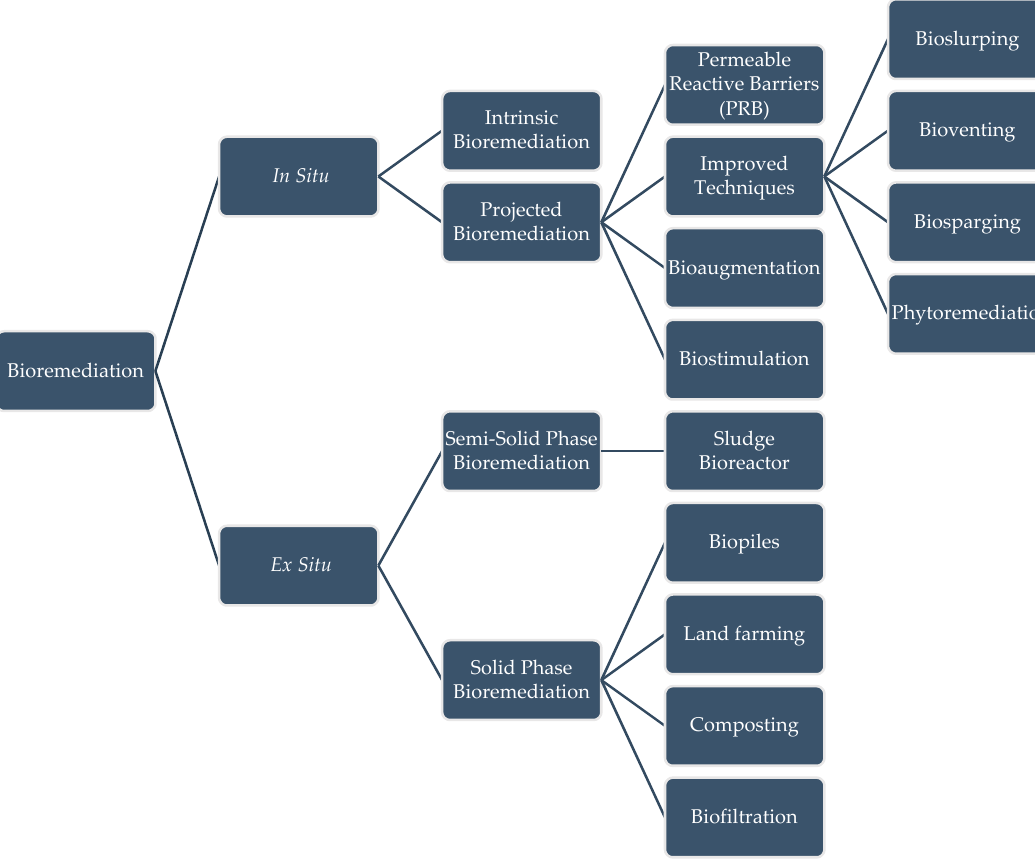
Figure 2. Di ff erent bioremediation Figure 2. Different bioremediation strategies.